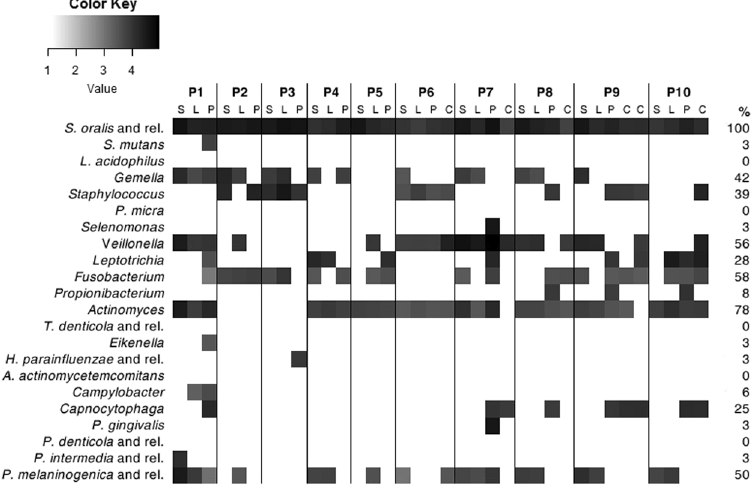
Figure 4. Heatmap of the OralArray data. Samples were collected from ten subjects (P1-P10) at four oral sites (S: saliva, L: lingual plaque, P: supragingival plaque, C: healing cap) and analyzed by OralArray. Fluorescence intensities (IFs) were normalized over the IFs of the Zip Code 63, as described in the Methods section. The mean values of the logarithm of IFs (n = 4) for each bacterial target are plotted in a scale of grey, by using R “made4” package. Prevalence of bacterial targets in the oral samples are also reported, expressed in percentage (%).